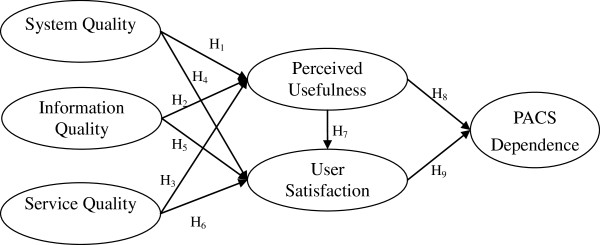
Research framework.